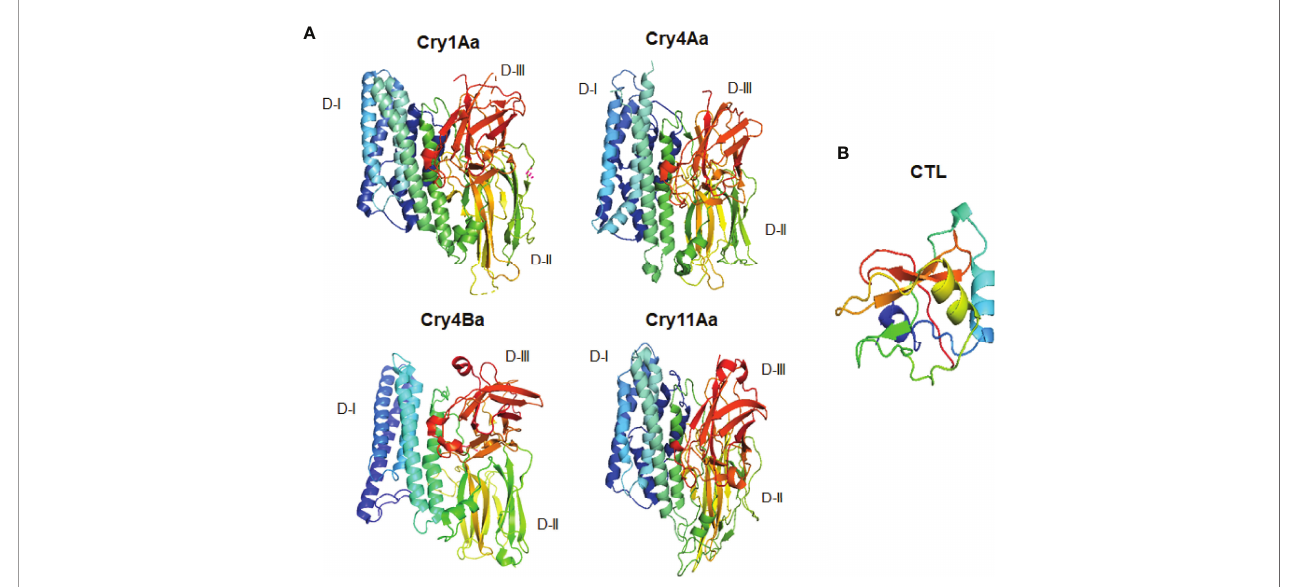
FIGURE 2 | Three dimensional structural comparisons between different Cry toxins and CTL domain. (A) Cry1Aa (PDB: D6J4), Cry11Aa (PDB: 1DLC), Cry4Aa (PDB: 2C9K), Cry4Ba (PDB: 1W99); (B) CTL domain (PDB: